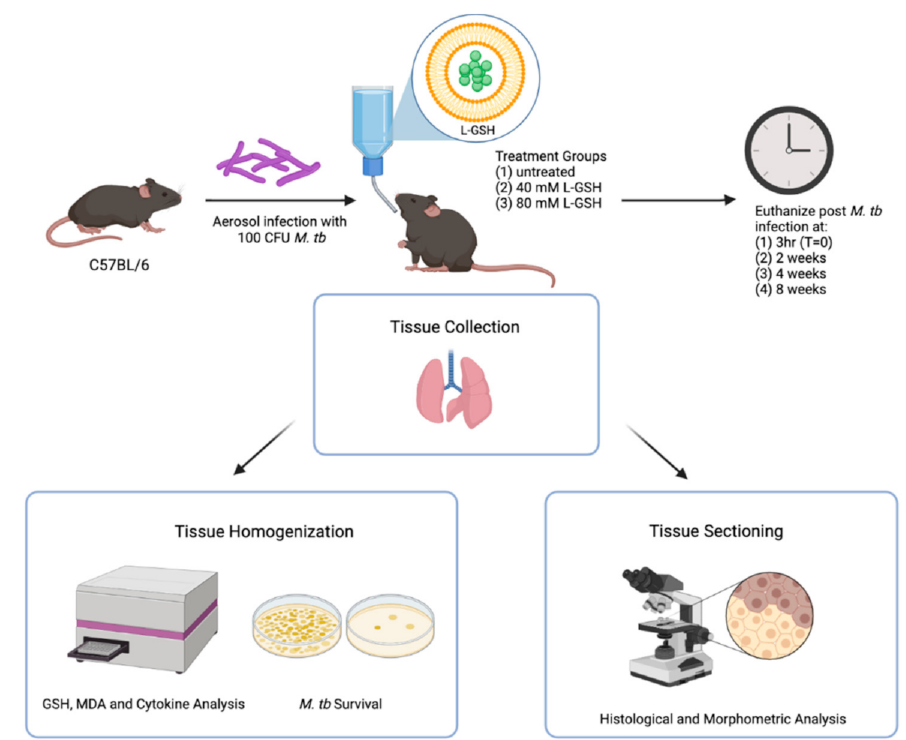
Figure 1. Schema of the study design. The C57BL/6 mice were infected with 100 CFU H37Rv M. tb strain. The mice were treated with either 40 mM L-GSH, 80 mM L-GSH, or untreated before euthanizing at 3 h (T = 0), 2-, 4-, and 8-weeks post-infection. The lungs were collected and either homogenized or sectioned for GSH, MDA, and cytokine analysis, or histological and morphometric analysis, respectively. The sample size (n) includes 4 mice in the 3 h group and 6 mice, each for the 2, 4, and 8 weeks groups. The figure was created using